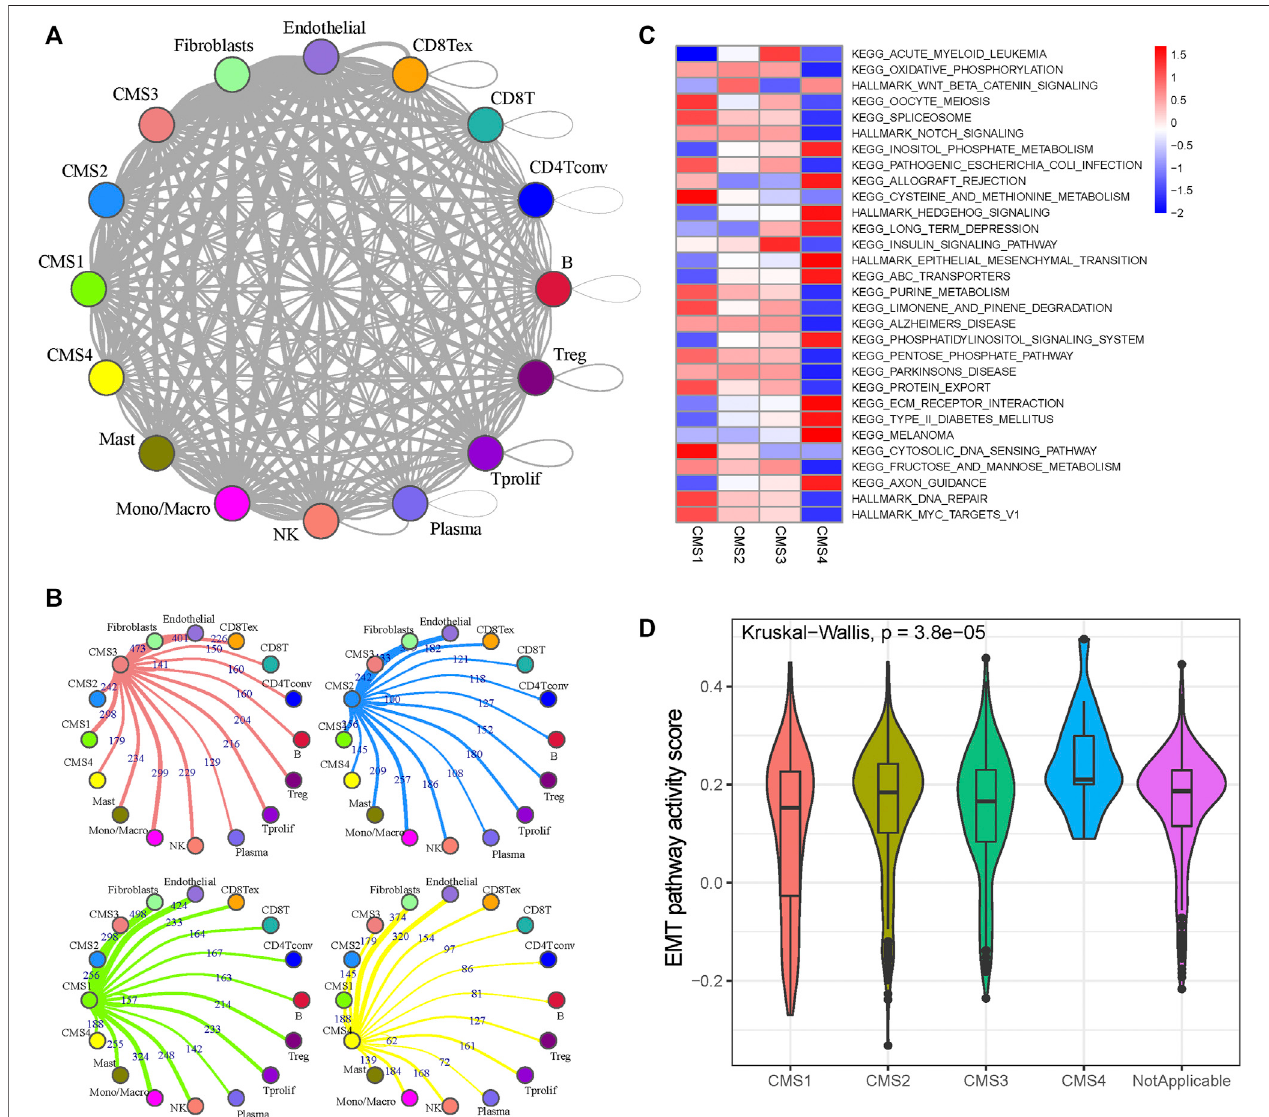
FIGURE 2 | Cell-cell interaction and pathway activity analysis (A) Cell-cell interaction network of different cell types. The node size represents the number of interactions. The width ofthe edge represents the number ofsigni fi cantligand-receptor interactions in the 2 cell types (B) Cell-cell interaction network of CMS and other cells (C) Differences in the enrichment of the pathways across the fi ve molecular subtypes (D) Violin plots of GSVA enrichment scores of the EMT pathway of the four molecular subtypes.